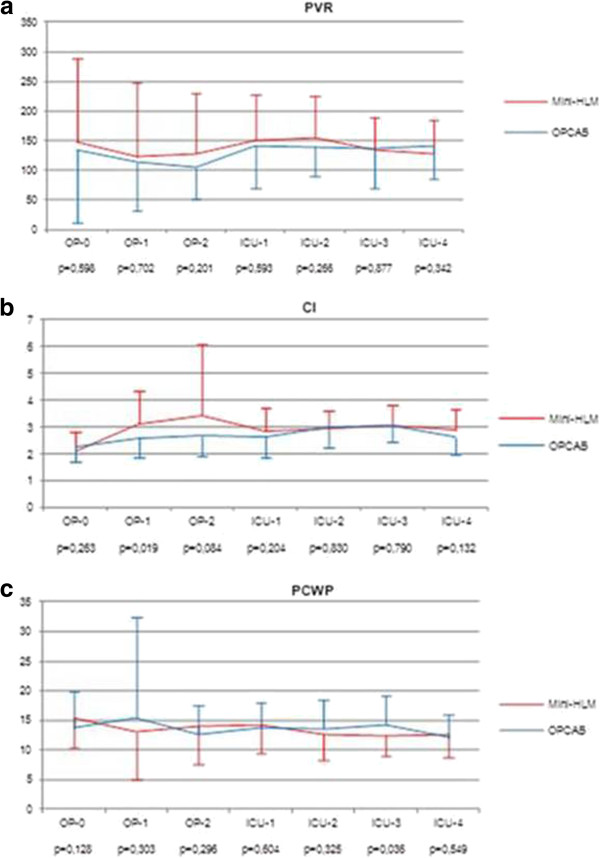
Perioperative hemodynamic measurements using a pulmonary artery catheter (Edwards Lifesciences). There are no significant differences between the two groups at most time points (p > 0,05), few differences (p < 0,05) have no clinical significance because the corresponding values remain in the normal range. a: Pulmonary vascular resistance (PVR), y-axis in [dyne*sec/cm5]; b: Cardiac index (CI), y-axis in [l/min/m2 BSA]; c: Pulmonary capillary wedge pressure (PCWP), y-axis in [mmHg]. "OP-0", skin cut; "OP-1", post Mini-HLM/OPCAB-stabilizer; "OP-2", skin closure; “ICU-1”: one-hour post-op; "ICU-2": six-hour post-op; "ICU-3”: 12-hour post-op; "ICU-4": 24-hour post-op.